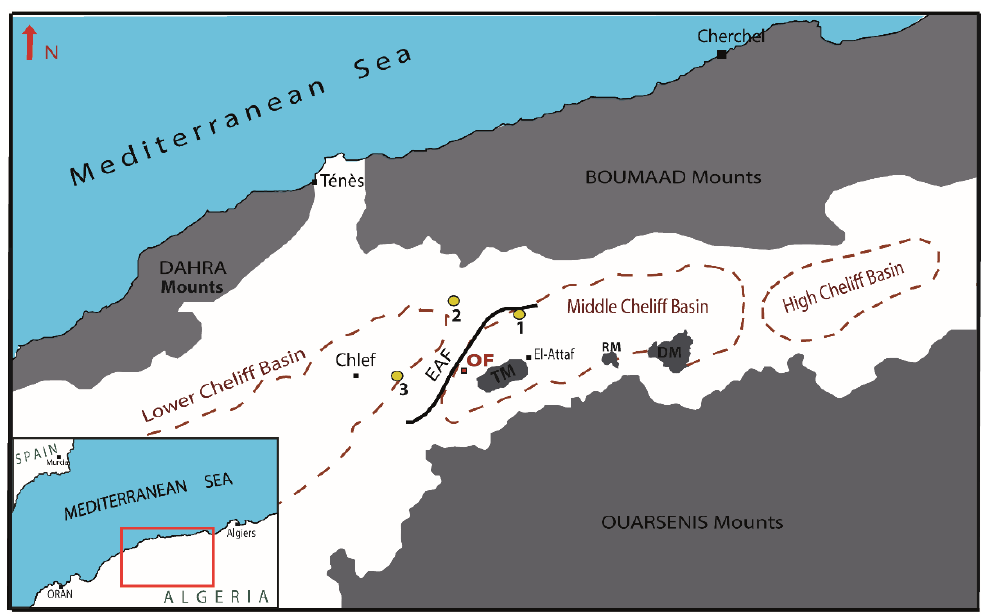
Figure 1. Situation of the Middle Cheliff Basin. Yellow circles represent the major earthquakes in the area: (1) The 1934 Carnot (I0 = IX) earthquake, (2) The 1954 Orléansville (Ms 6.7) earthquake, (3) The 1980 El-Asnam earthquake (Ms 7.3). EAF: El-Asnam fault (black line). OF: Oued-Fodda city. TM: Temoulga Massif. RM: Rouina Massif. DM: Doui Massif.